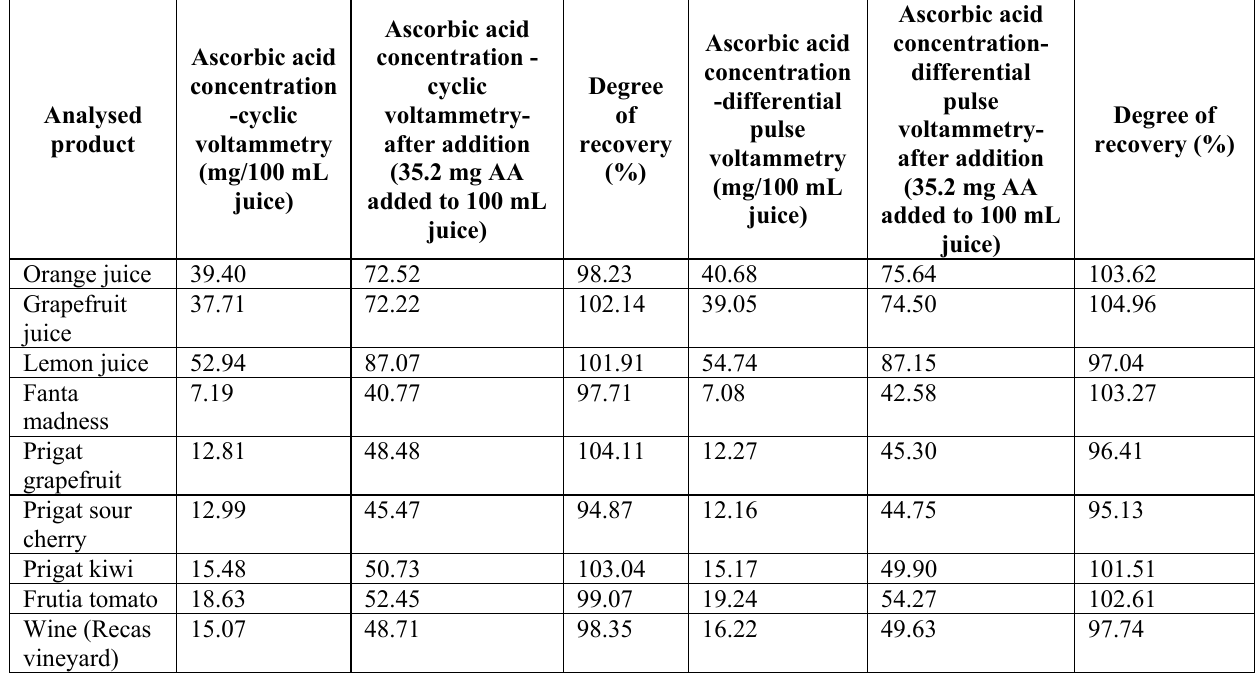
Table 4. Results obtained at ascorbic acid determination in natural juices, soft drinks and wines * by differential pulse voltammetry and cyclic voltammetry performed at a carbon paste